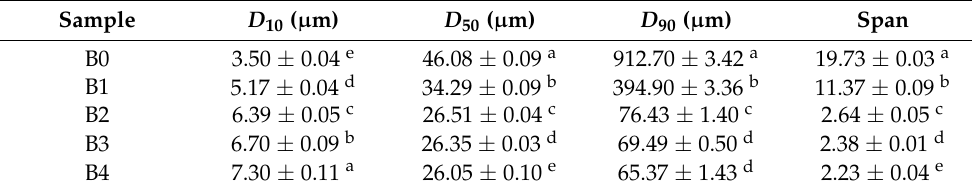
Figure 1. Particle size distribution patterns of the wheat bran. The B0, B1, B2, B3, and B4 are the wheat bran prepared under the rolling frequencies 0, 6, 9, 12, and 15 times/s D 10 , D 50 , and D 90 are mean particle sizes at 10%, 50%, and 90% of the volume distribution, respectively. Table 1. Particle size distribution of wheat bran.